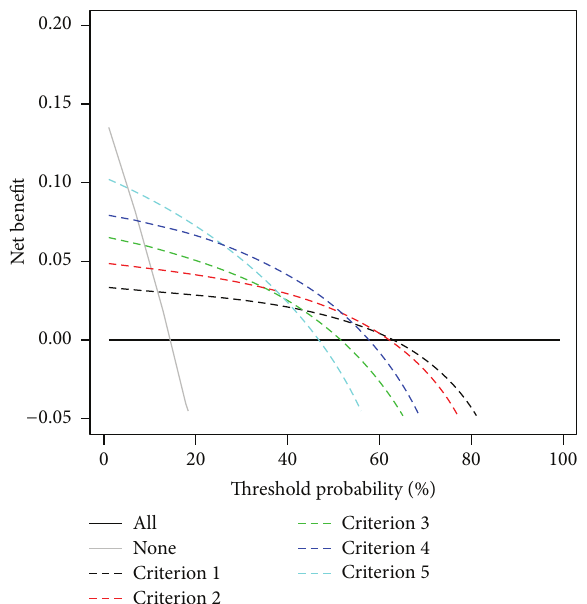
Figure 1: Decision curve analysis, demonstrating the net benefit, as measured by rate of nontreating men for low-risk prostate cancer, using the five decision-making strategies as listed in the legend. Threshold probability is the threshold probability of low- risk PC at which an individual considers the benefit of treatment for PC equivalent to the harm of overtreatment for low-risk disease, and thus it reflects how the individual weights the benefits and harms associated with this decision. The highest curve at any given threshold probability is the optimal decision-making strategy to maximize net